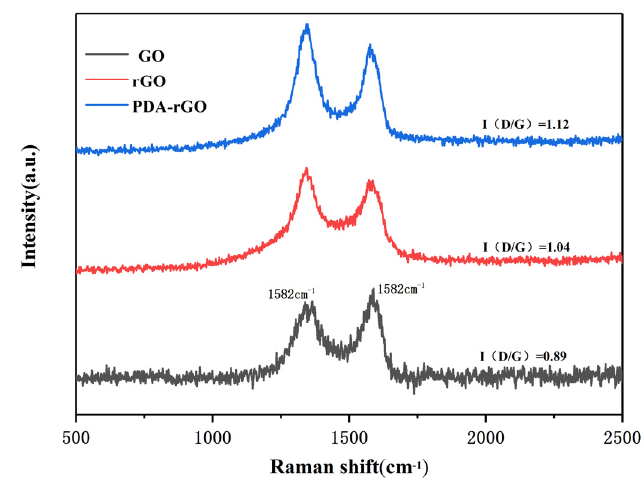
Figure 4. Raman spectra of GO, rGO and PDA − rGO.